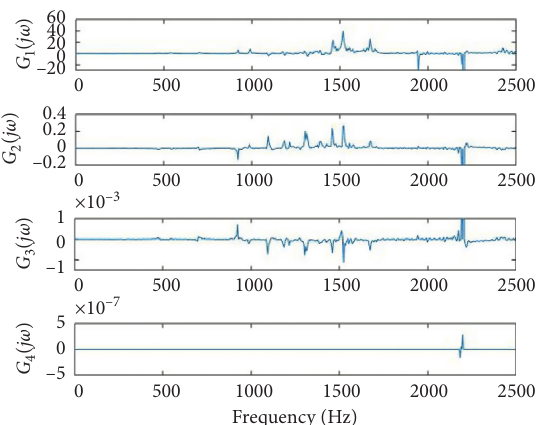
Figure 13: The NOFRFs of healthy pillar porcelain insulator in hammer detection.